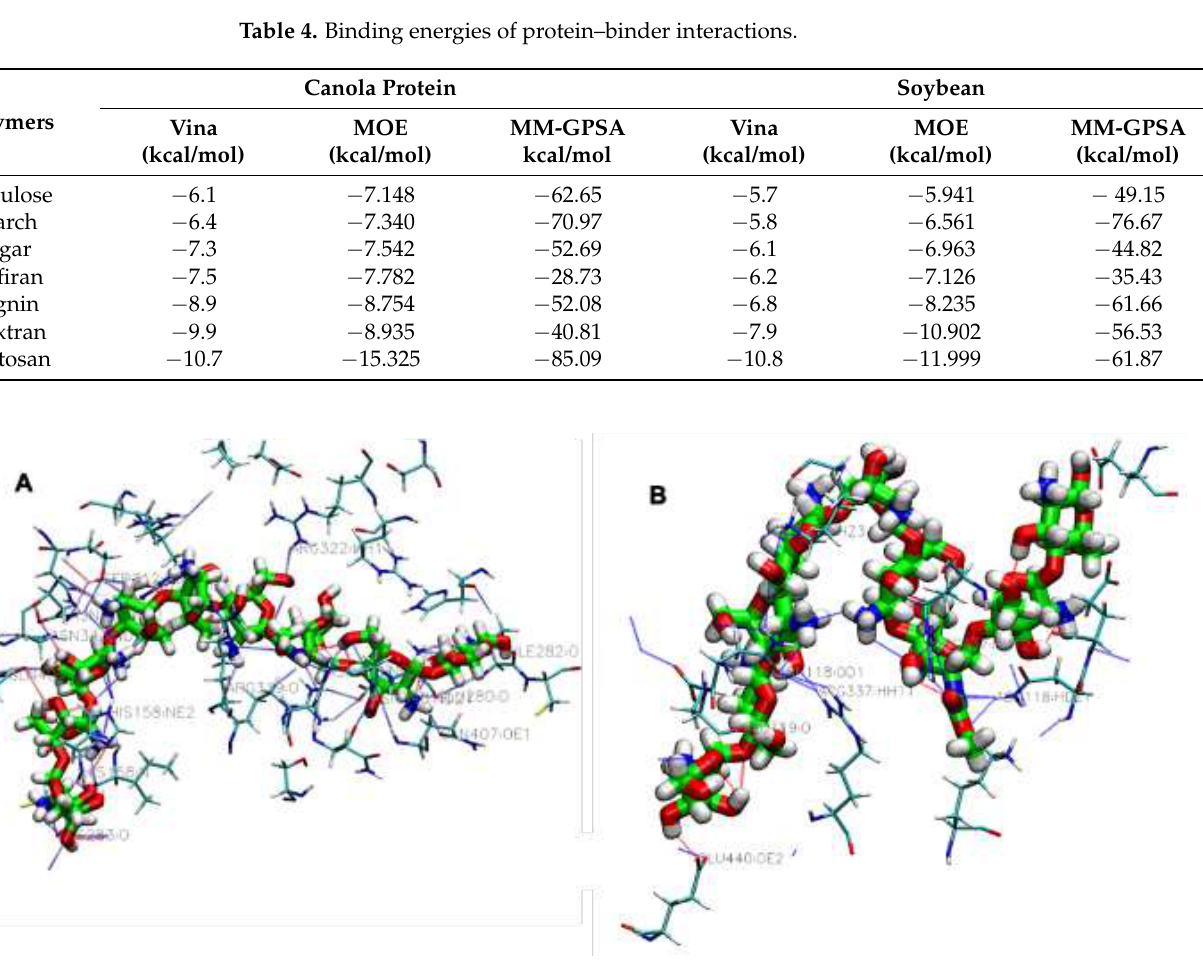
Figure 5. Three-dimensional view of protein–chitosan interactions: Canola protein ( A ), and Soybean protein ( B ).